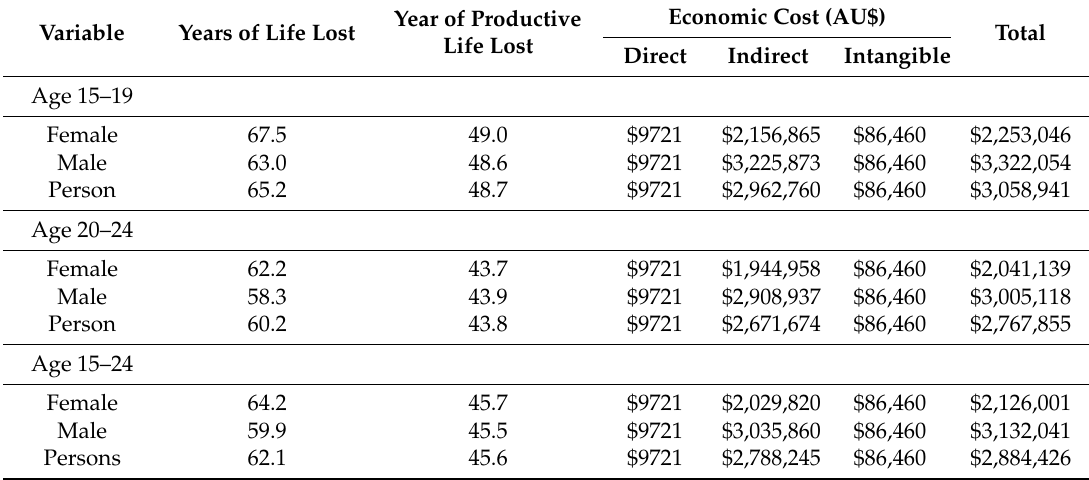
Table 3. The economic cost of a single youth suicide, Australia, 2014, by age and sex.